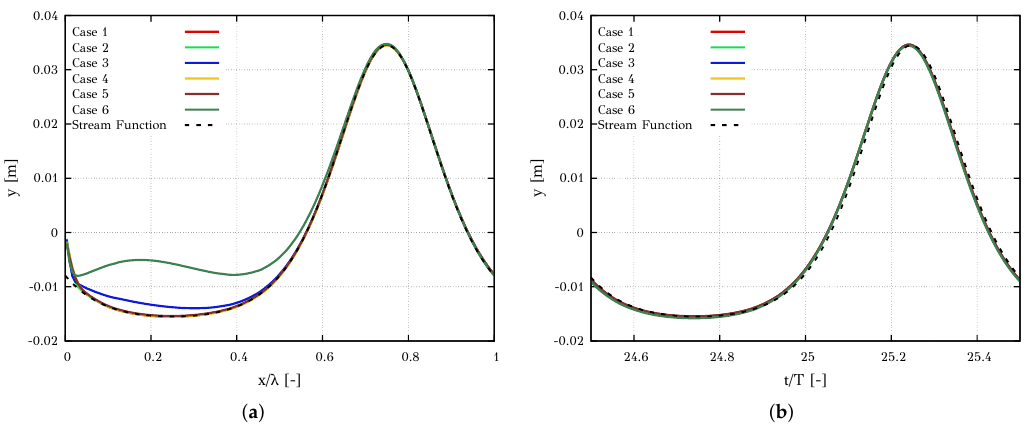
Figure 3. Influence of parameters α and n in the generation of a wave. Wave characteristics: T = 5 s, H = 0.05 m, d = 0.5 m, λ = 11.08 m. ( a ) Wave elevation inside the generation zone after 25 wave periods; ( b ) Wave elevation at a station after the generation zone.